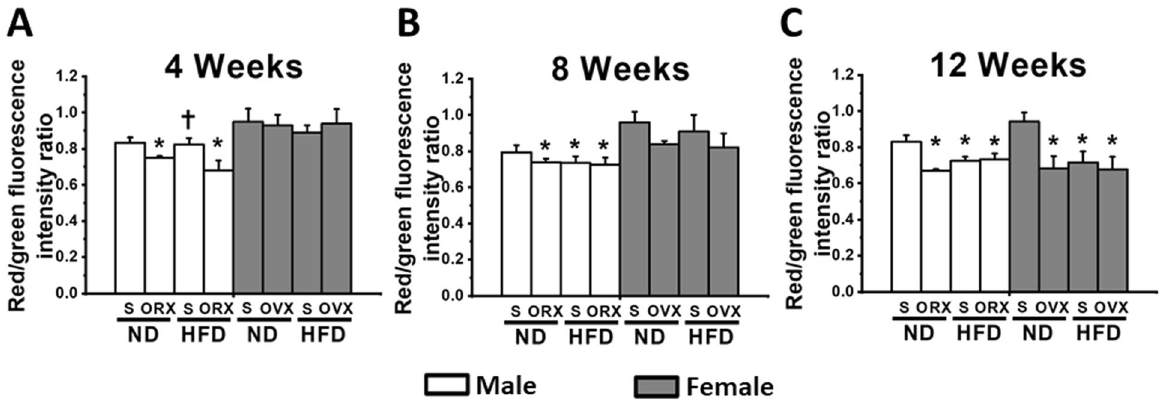
Fig. 4 The effect of sex hormone and dietary consumption on cardiac mitochondrial membrane depolarization at different time courses (4, 8, and 12 weeks). A The cardiac mitochondrial membrane depolarization at 4 weeks. B The cardiac mitochondrial membrane depolarization at 8 weeks. C The cardiac mitochondrial membrane depolarization at 12 weeks. * P < 0.05 vs sex-matched ND-Sham ( n = 6/ group). † P < 0.05 vs male orchiectomized rats ( n = 6/group). S sham, ND normal diet, HFD high-fat diet, ORX orchiectomized rats, OVX ovariectomized rats.